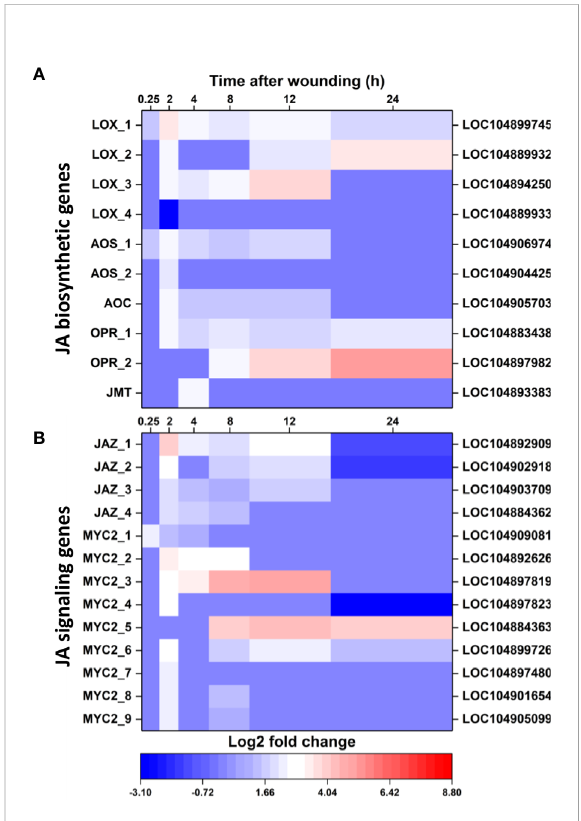
FIGURE 5 Changes in differential expression with respect to time after wounding for genes involved in jasmonic acid (JA) biosynthesis (A) and JA signaling (B) . Heat maps display the log 2 fold change in gene expression between wounded and control roots at 0.25, 2, 4, 8, 12 and 24 h after wounding for all pathway genes that exhibited a log 2 fold change in expression ≥ |1| at any time point. LOX, lipoxygenase; AOS, allene oxide synthase; AOC, allene oxide cyclase; OPR, 12-oxophytodienoic acid reductase; JMT, jasmonate O-methyltransferase; JAZ, jasmonate ZIM domain- containing protein. For all analyses, n =